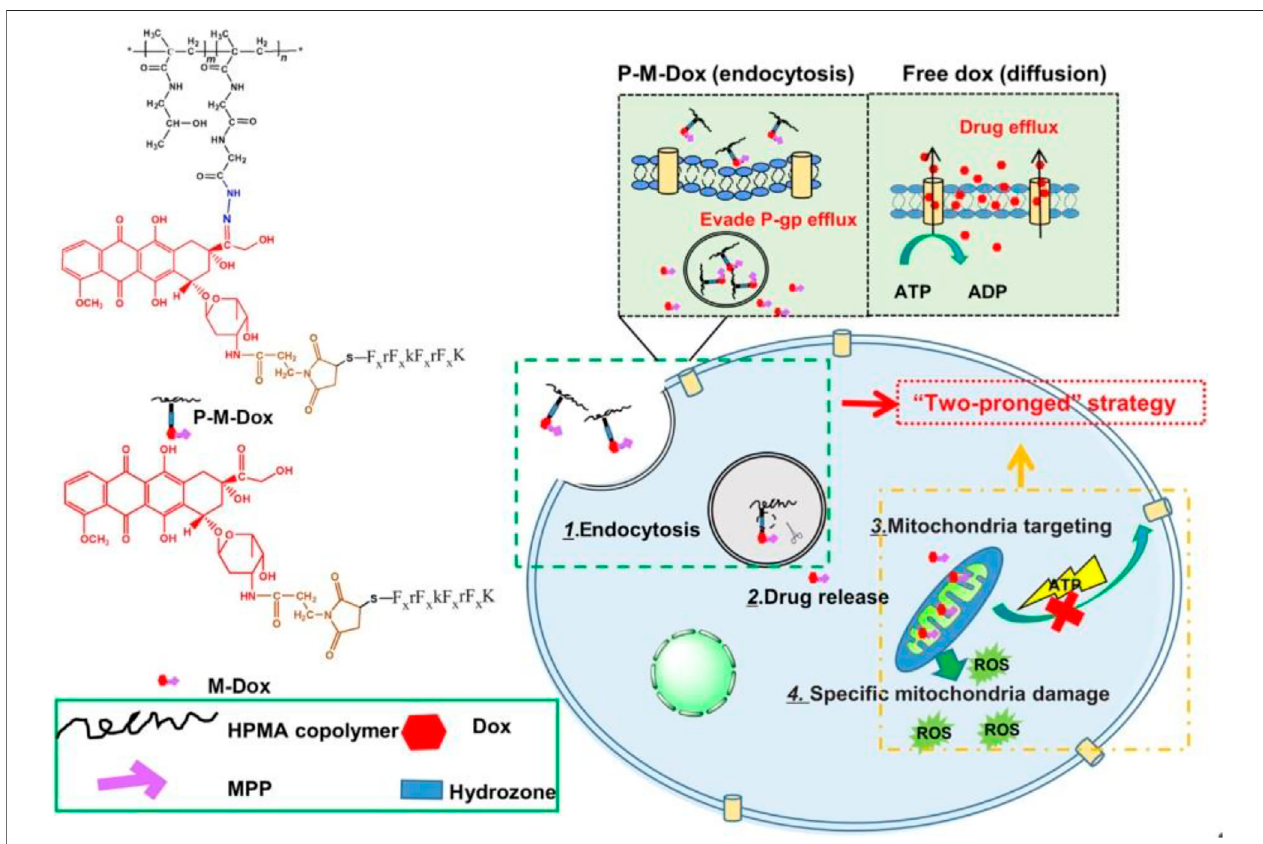
FIGURE 4 | P-M-Dox overcomes multidrug resistance through simultaneous drug-ef fl ux circumvention and mitochondrial targeting (Zhou et al., 2019).